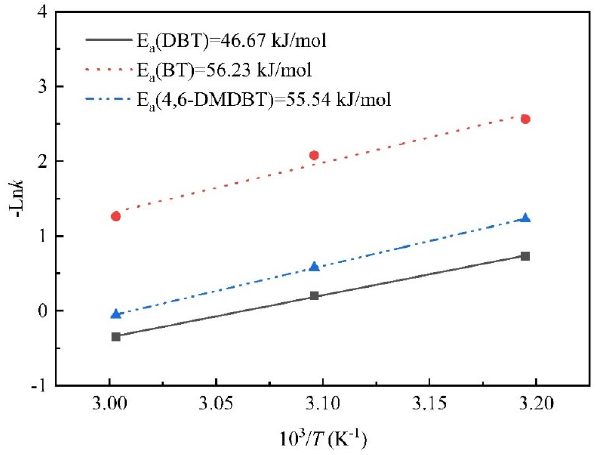
Figure 8. Arrhenius activation energies for DBT, BT, and 4,6-DMDBT oxidation.